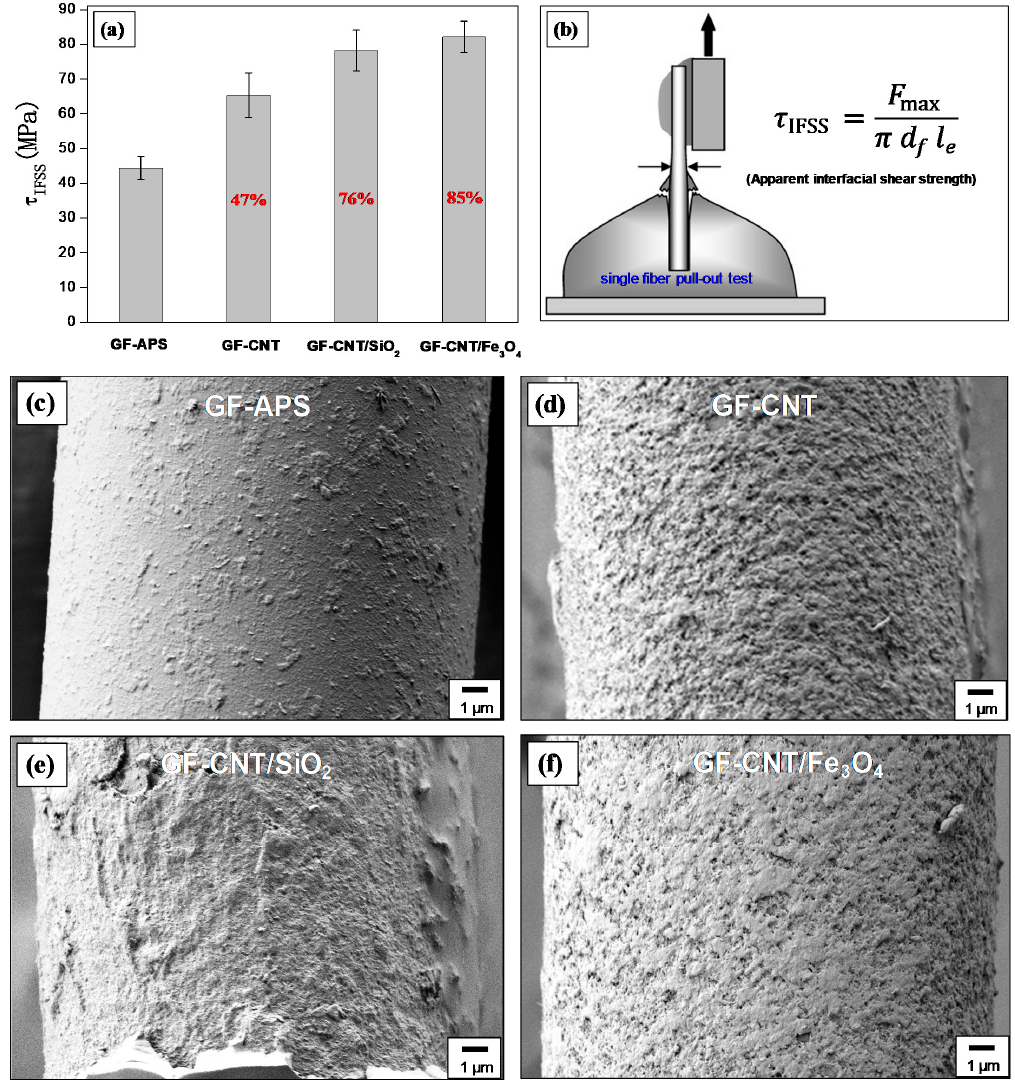
Figure 7. ( a ) Apparent interfacial shear strength ( τ app ), and ( b ) illustration of the experimental configuration; ( c – f ) FE-SEM fractured surface morphologies of GF-APS, GF-CNT, GF-CNT/SiO 2 and GF-CNT/ Fe 3 O 4 , respectively.